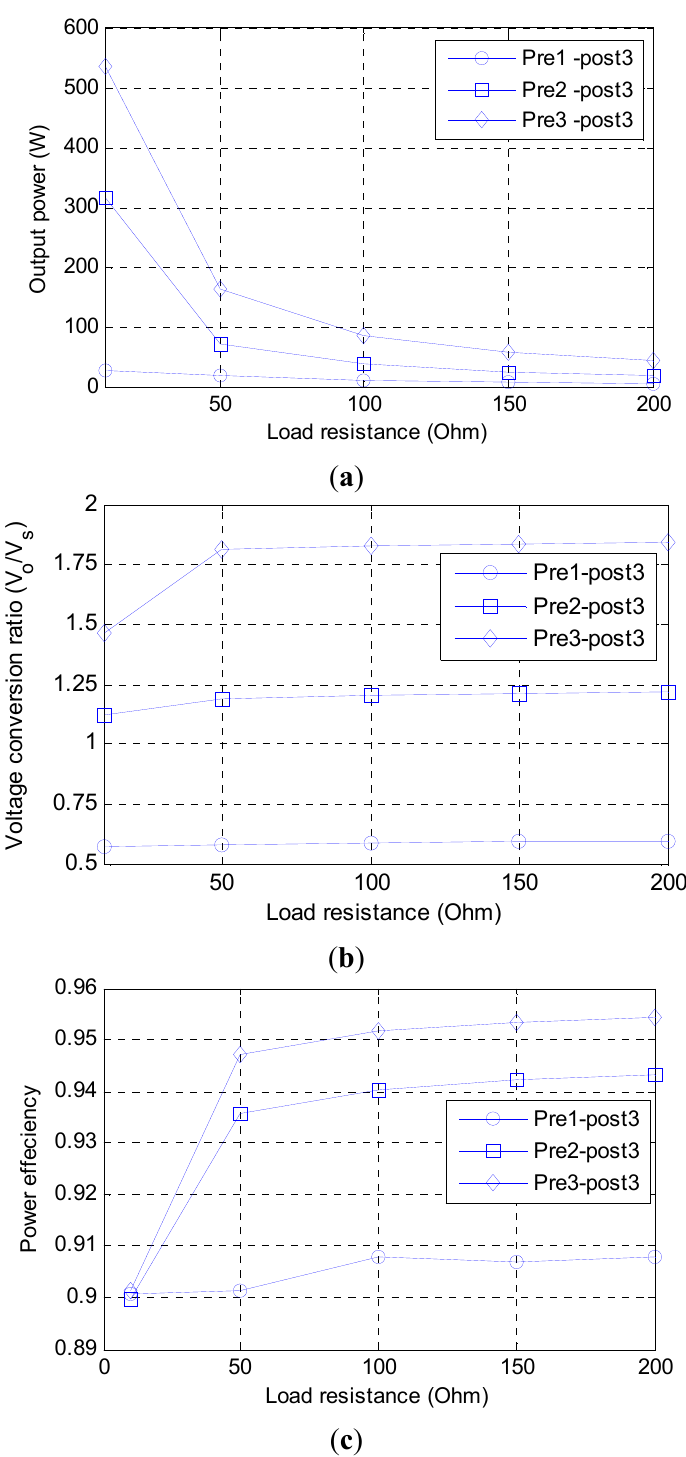
Figure 9. The output power, voltage conversion ratio and power efficiency versus load resistor of n = 1, 2, 3 to pre-stage, m = 3 to post-stage: ( a ) the output power versus load resistor; ( b ) conversion ratio versus load resistor; and ( c ) the power efficiency versus output current of 1, 2, 3 pre-stage, 3